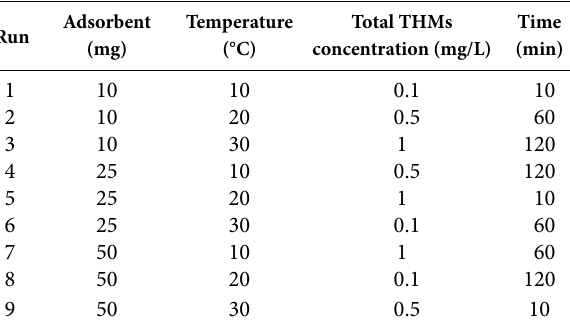
Table 1. Batch adsorption test conditions based on the Taguchi de- sign of the